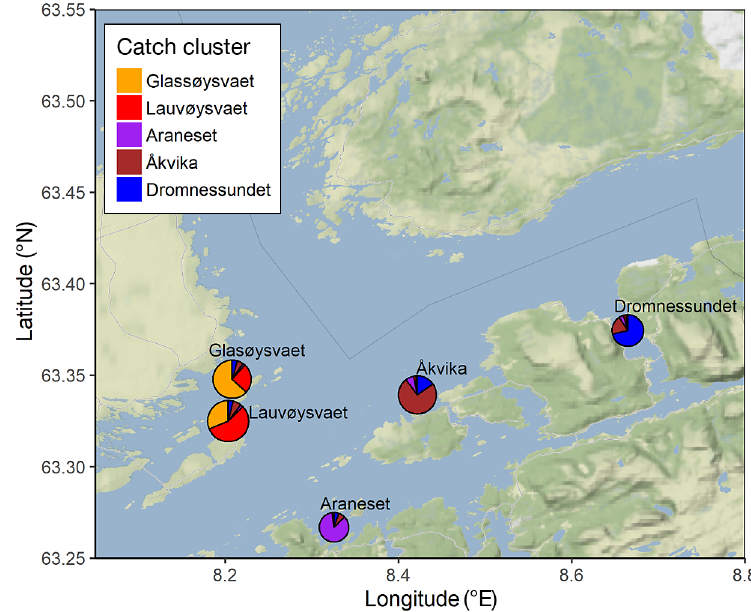
Fig. 6. Origin of cod detected at the 5 different spawning grounds. Size of pie charts are scaled to the number of fish